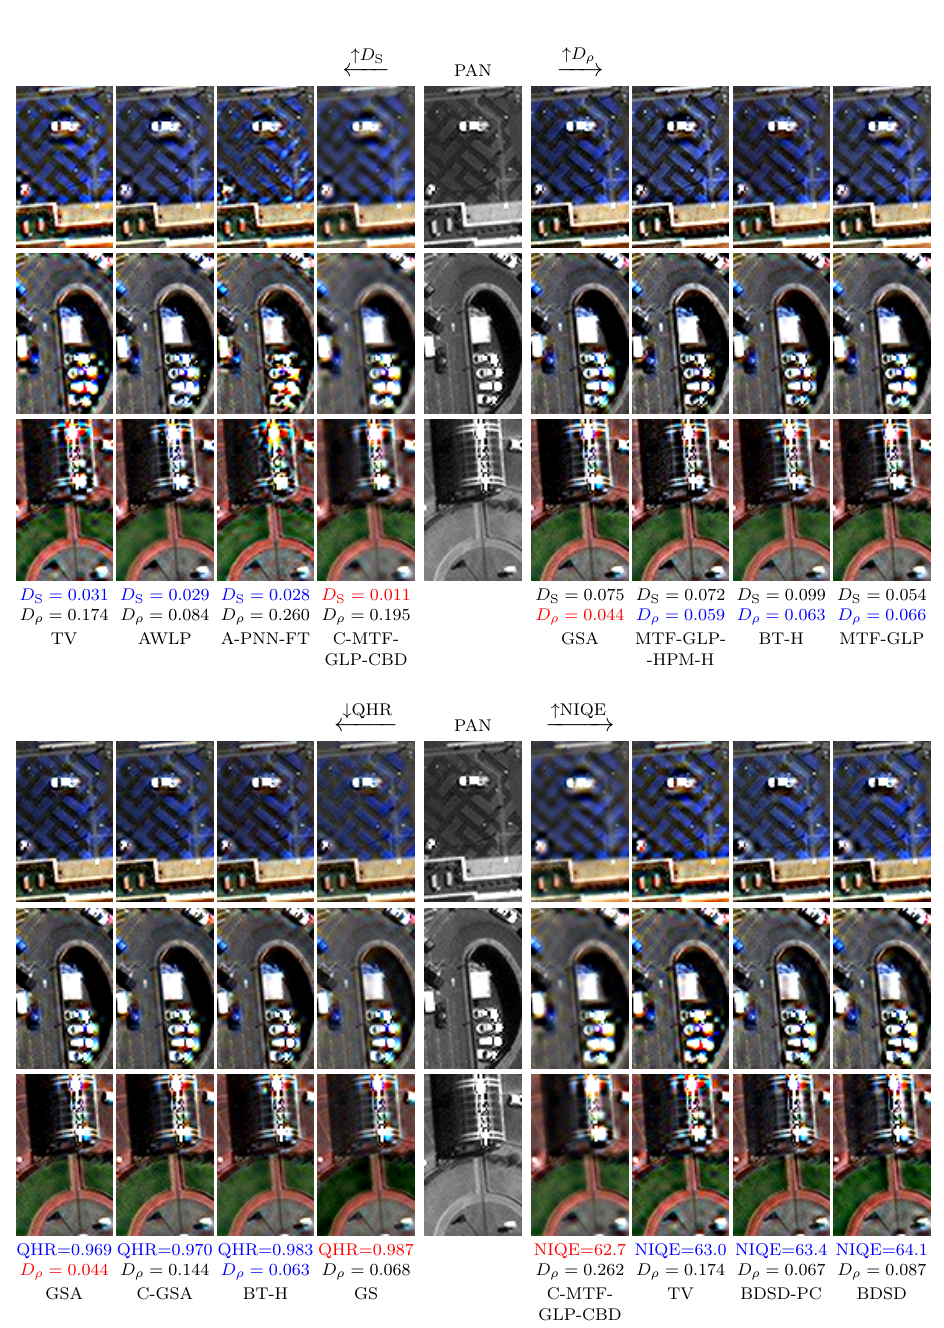
Figure 7. Pansharpening results on crops from a full-resolution WV3 Adelaide tile. The reference PAN is in the middle column. In the top half, the four best results in terms of D S and D ρ are on its left and right, respectively, with best scores (in red) closer to the reference. In the bottom half are shown the top results according to QHR ( leftward ) and NIQE ( rightward ). Best scores are highlighted in red; second, third, and fourth best results are in